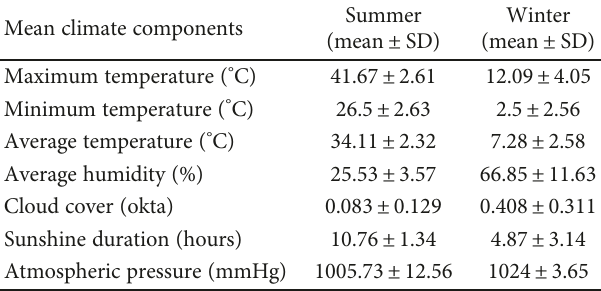
Table 1: Mean climate characteristics in summer and